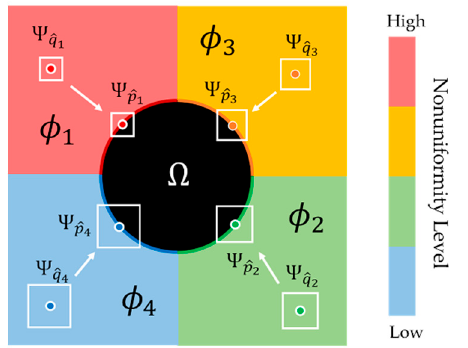
Figure 6. Illustration of a multi-patch match in single iteration.